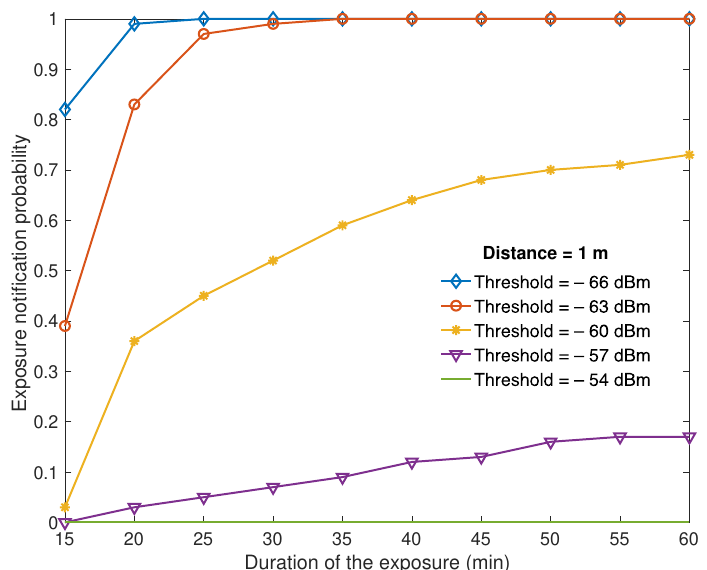
Figure 6. The probability of exposure notification vs. the duration of the exposure at a proximity detector for a beaconing tag at a distance of 1 m.